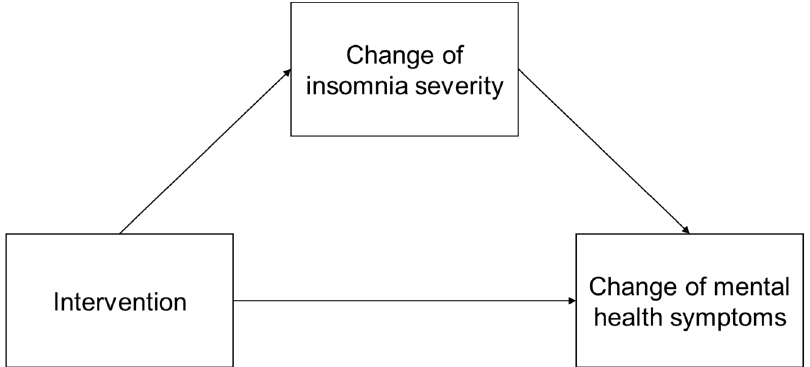
Figure 1. Hypothetical